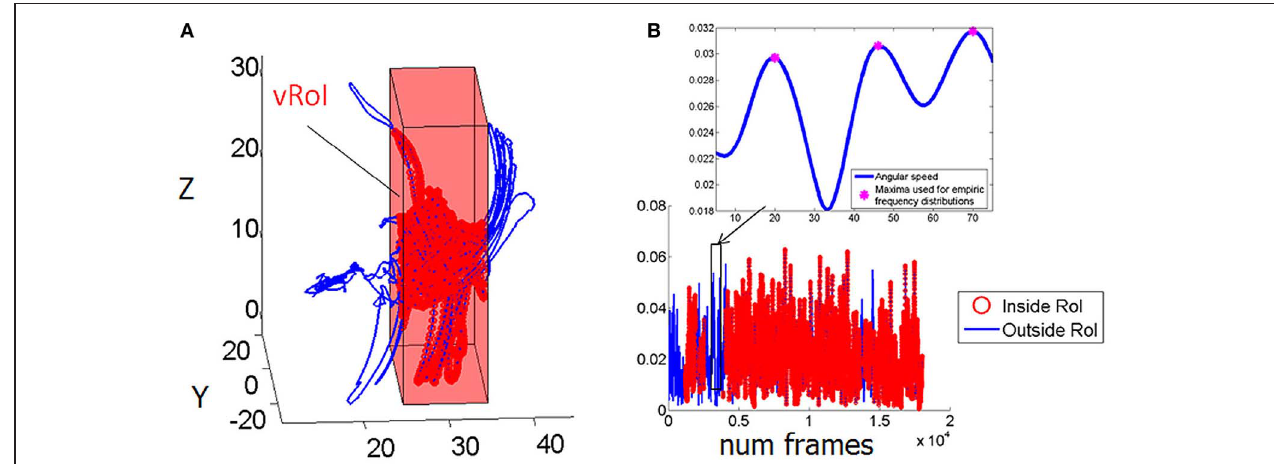
FIGURE 3 | Velocity dependent micro-rotations of the hand registered in real time while exploring the peripersonal space. (A) Virtual Region of Interest (vRoI) invisible to the subject marked as a cube colored in red. Hand positional trajectories captured at 240Hz inside and outside the vRoI as the child continuously explores the space during 83.3s. (B) Hand rotations displayed as angular speed (radians) obtained by parameterizing